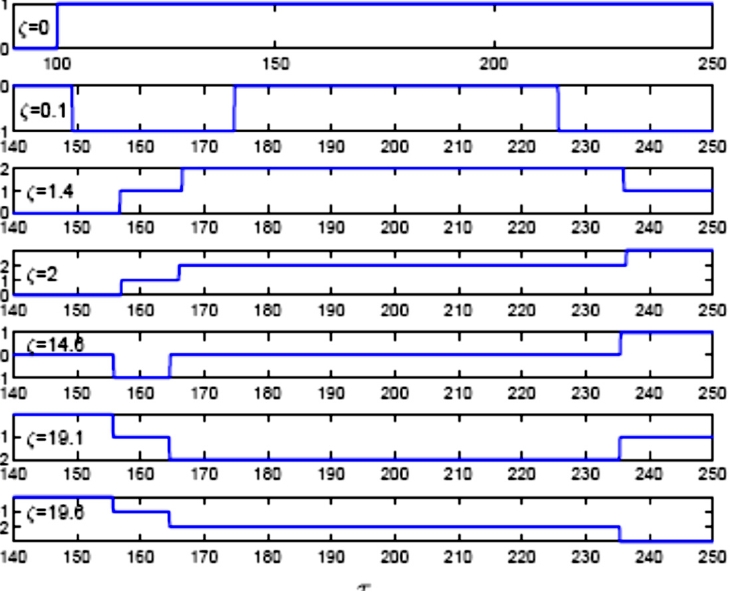
Figure 7. The trajectories of the temporal phase with the drive branch at various prolonged spaces in 23 Na vapour, where π units are used to express the